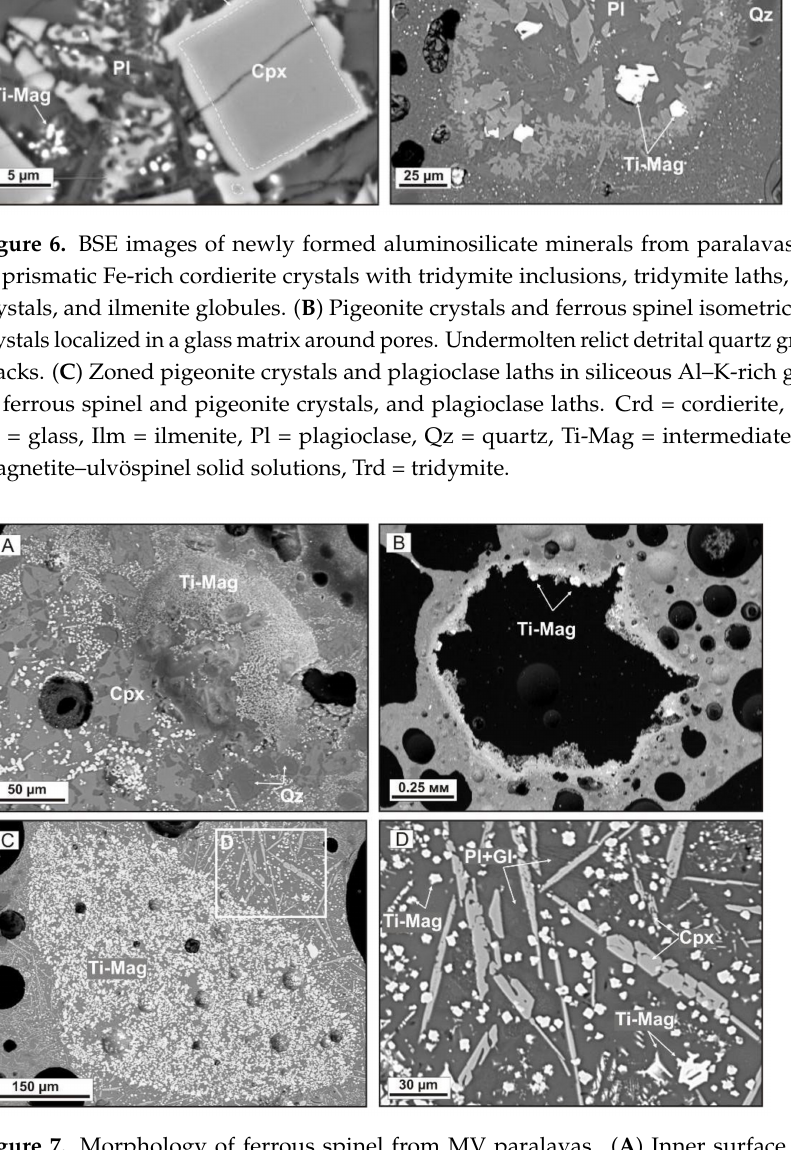
Figure 7. Morphology of ferrous spinel from MV paralavas. ( A ) Inner surface of an open pore in a glass matrix encrusted with pigeonite and ferrous spinel. ( B ) Pore in a glass matrix rimmed by ferrous spinel. ( C ) Cluster of ferrous spinel crystals. ( D ) Newly formed elongate hopper-like crystals of pigeonite and isometric and hopper crystals of ferrous spinel in a glass matrix with abundant plagioclase laths. BSE images. Cpx = pigeonite, Gl = glass, Pl = plagioclase, Qz = quartz, Ti-Mag = intermediate members of the magnetite–ulvöspinel solid